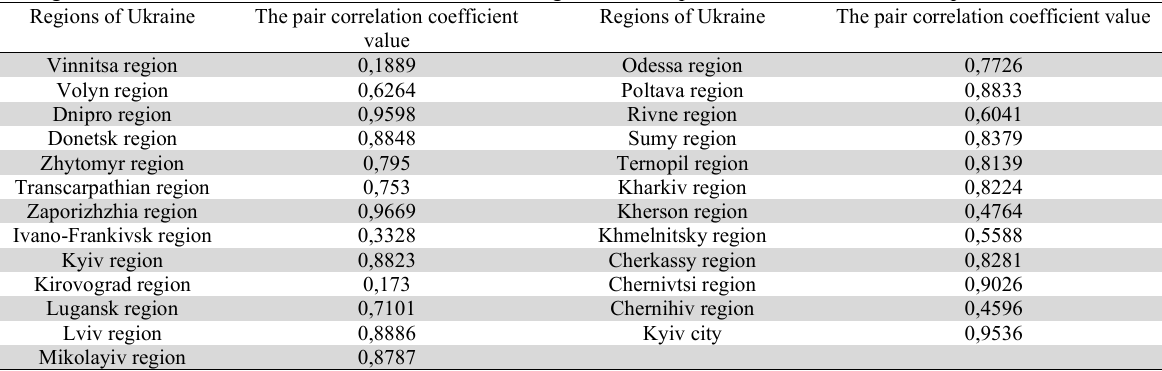
The tightness of the link between the individual levels of regional development and the overall development level of Ukraine Regions of Ukraine The pair correlation coefficient